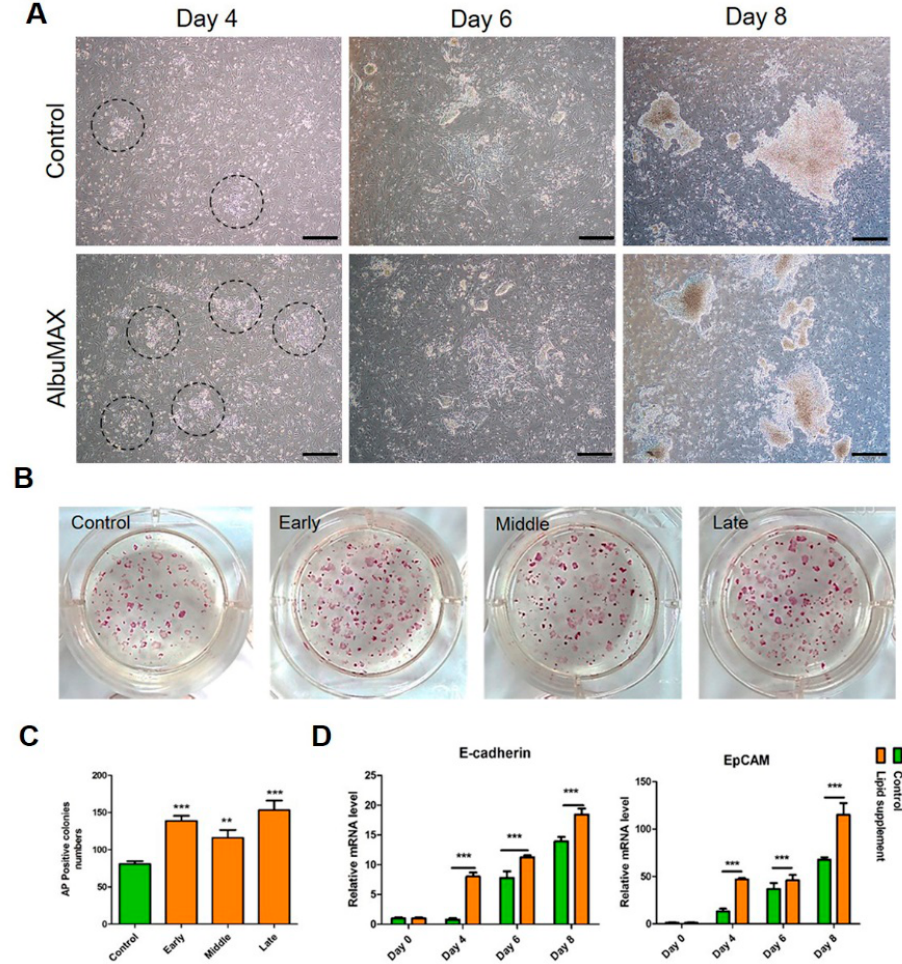
Figure 5. AlbuMAX promotes mesenchymal–epithelial transition (MET) during reprogramming. ( A ) MET process in iPSCs. Black circles indicated cells in the MET process. Scale bar, 500 μ m; ( B ) AP staining of iPSCs following treatment of AlbuMAX at different stages; ( C ) Analysis of AP-positive colonies. ** p < 0.01, *** p < 0.001; ( D ) Quantitative RT-PCR analyzed the expression of E-cadherin and EpCAM during reprogramming. Day 0, Day 4, Day 6 and Day 8 indicated the time that AlbuMAX was added. *** p < 0.001.